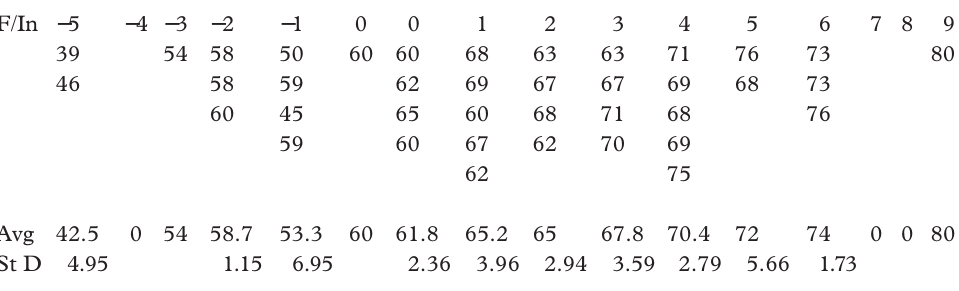
Table 2. Mapping of compensated DSandEN marks to comments F/In −